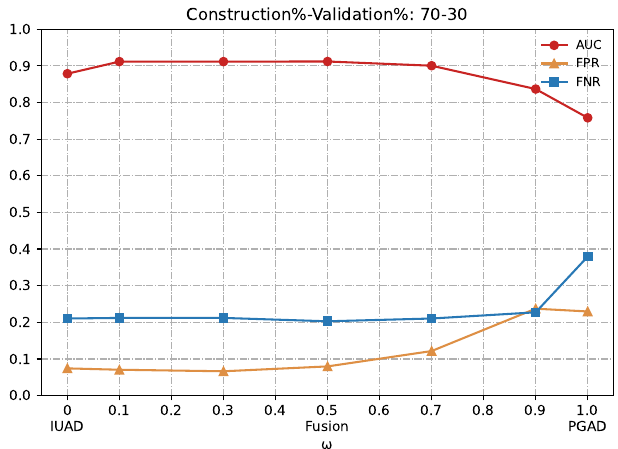
Figure 8. Detection results of the IUAD, the PGAD and the fusion model in terms of AUC, FPR, FNR